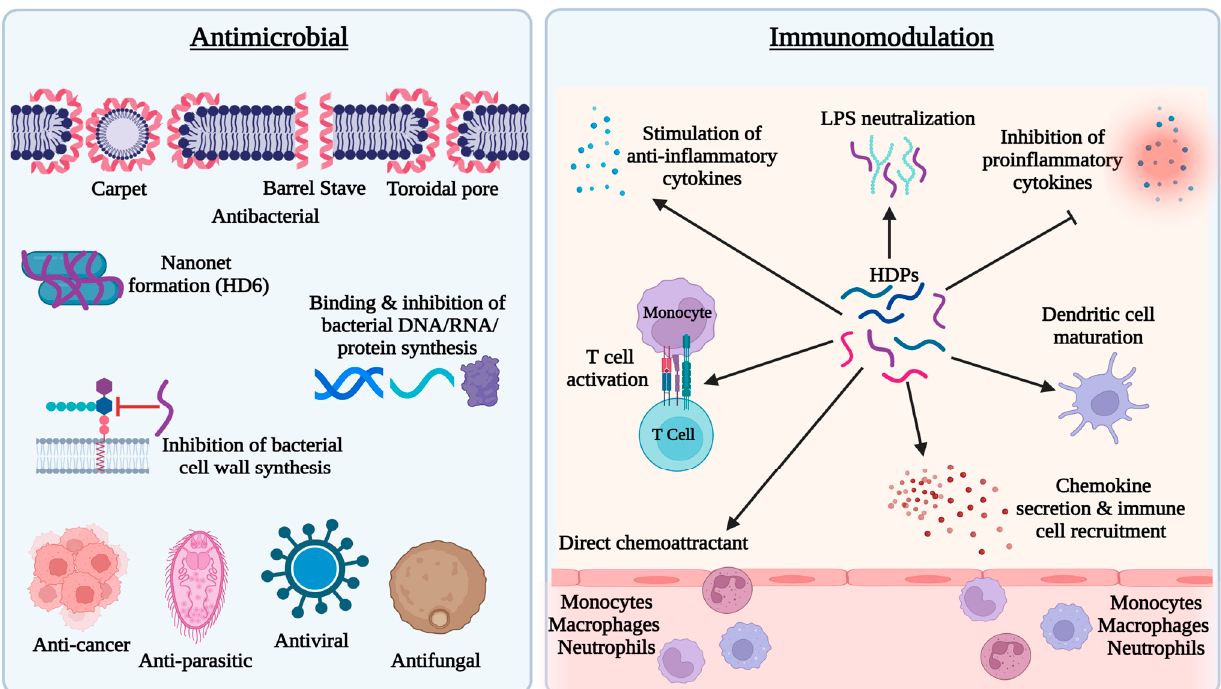
Figure 1. Antimicrobial and immunomodulatory activities of host defense peptides (HDPs). HDPs possess direct antimicrobial activity against bacteria, fungi, viruses, and parasites mainly through membrane disruption. A few HDPs also inhibit bacteria by forming nanonets or targeting bacterial DNA, RNA, proteins, or lipid II of the cell wall. Immunomodulatory effects of HDPs mainly include recruitment and activation of immune cells and regulation of inflammatory response.